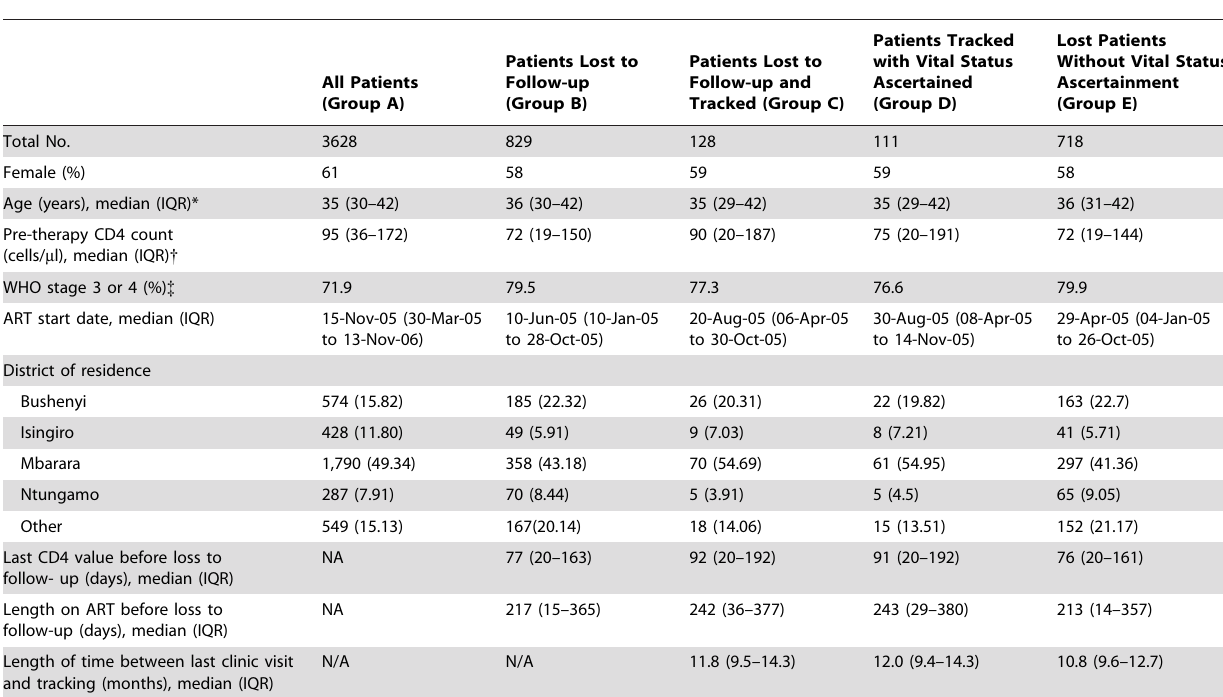
Table 1. Patient